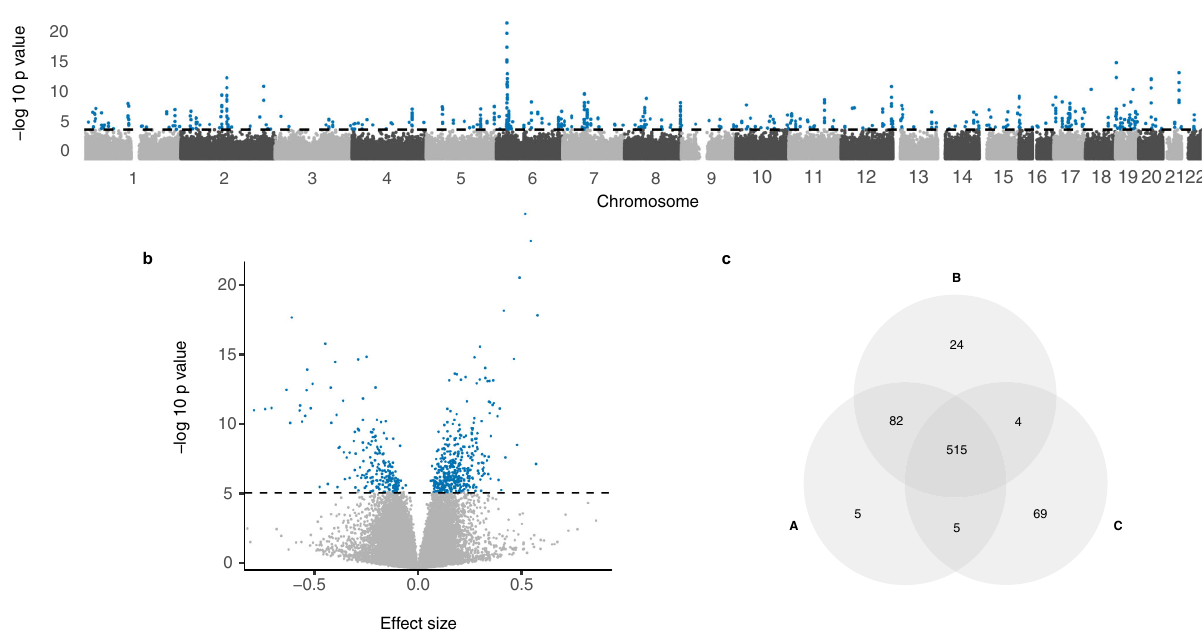
Fig. 3 Associations with ART and epigenome-wide DNA methylation in newborns. The P values (calculated from t statistics) were derived from two- sided t tests for comparing the DNA methylation levels between ART conceived ( n = 962) and naturally conceived newborns ( n = 983), with adjustment for maternal age, maternal smoking, maternal BMI before pregnancy, child sex, parity, and plate ID. a Manhattan plot with − log 10 P values plotted against the genomic position. b Volcano plot displaying the magnitude of the effect sizes against their corresponding − log 10 P value. The horizontal dashed line indicates FDR < 0.01. Blue dots indicate signi fi cant CpGs at FDR < 0.01, while gray dots indicate nonsigni fi cant CpGs. The dashed lines represent a genome- wide signi fi cance cut-off of FDR < 0.01. c Overlap of signi fi cant CpGs in association with ART from a Wald test corrected for multiple hypotheses (FDR < 0.01) for three different models. A: adjusted for maternal age, maternal smoking, maternal BMI, child sex, parity, and plate ID. Same models as ( a ) and ( b ). B: adjusted for the covariates in A and gestational age at birth. C: adjusted for the covariates in A and gestational age at birth, birthweight, maternal educational level, paternal age, and cord blood cell composition. Source data are provided as a Source Data fi